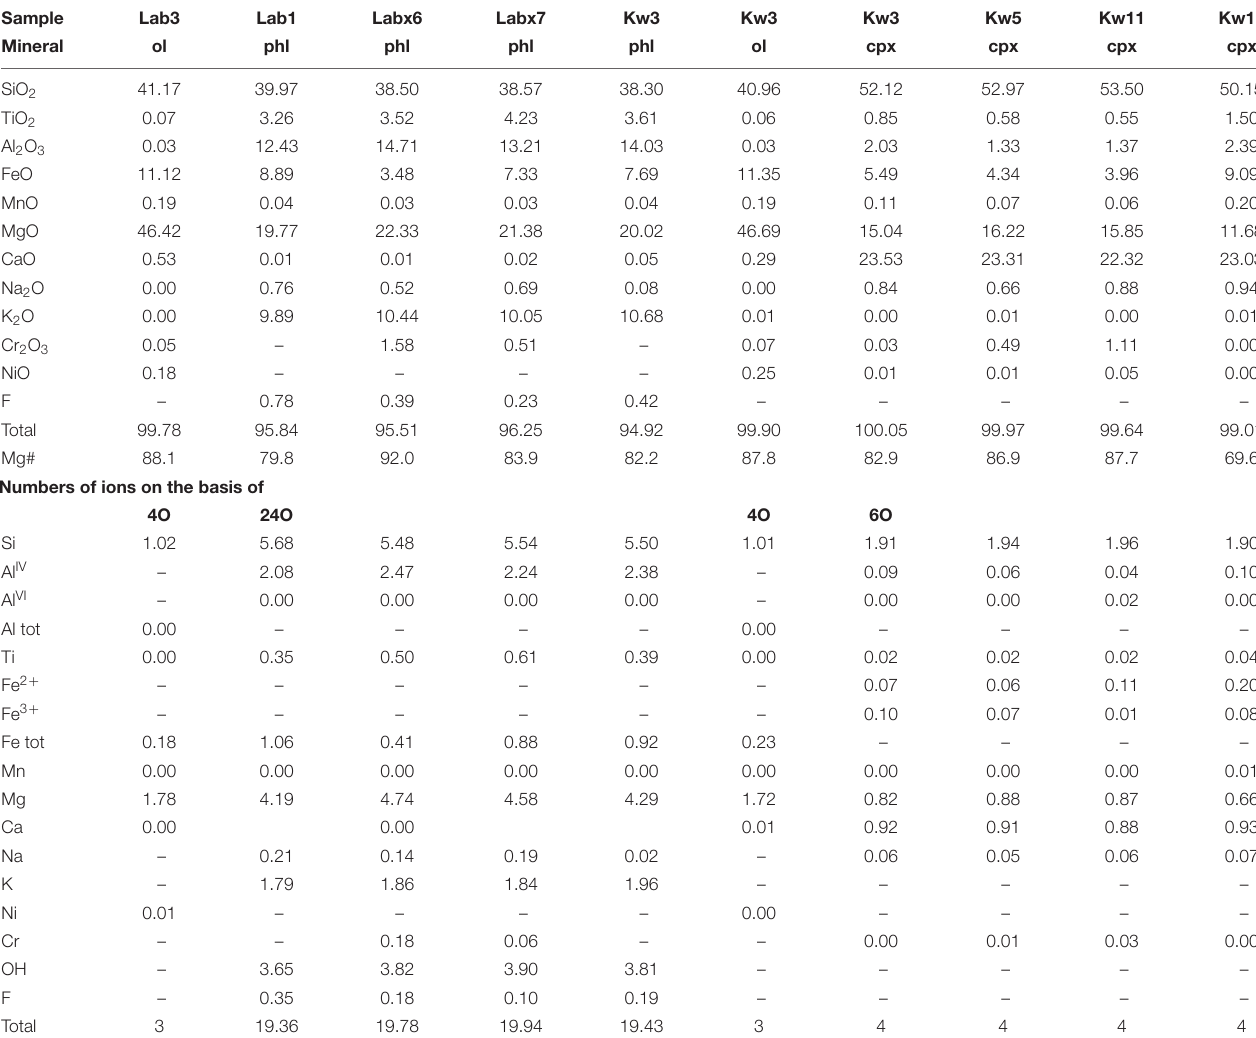
TABLE 2 | Representative major element compositions of